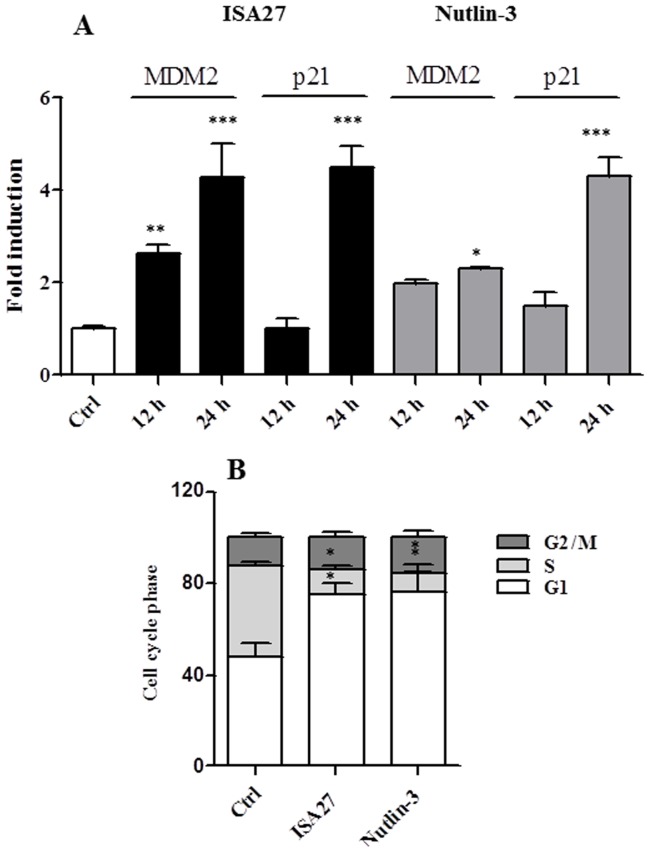
ISA27 restores p53 function in GBM cells.
4A) ISA27 induces p53 target gene expression: Real-time PCR analyses showed a statistically significant increase in MDM2 and p21 mRNA levels following short-term ISA27 treatment in U87MG cells. 4B) ISA27 induces cell cycle arrest: Cell cycle analysis (24 h) revealed a statistically significant increase in the G1 fraction and a nearly complete depletion of the S-phase population in short-term-treated U87MG cells.